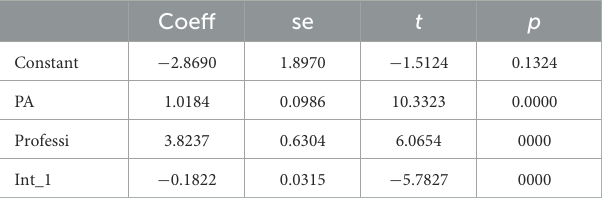
TABLE 4 Genuine acting and personal accomplishment, with professional growth as the moderator.